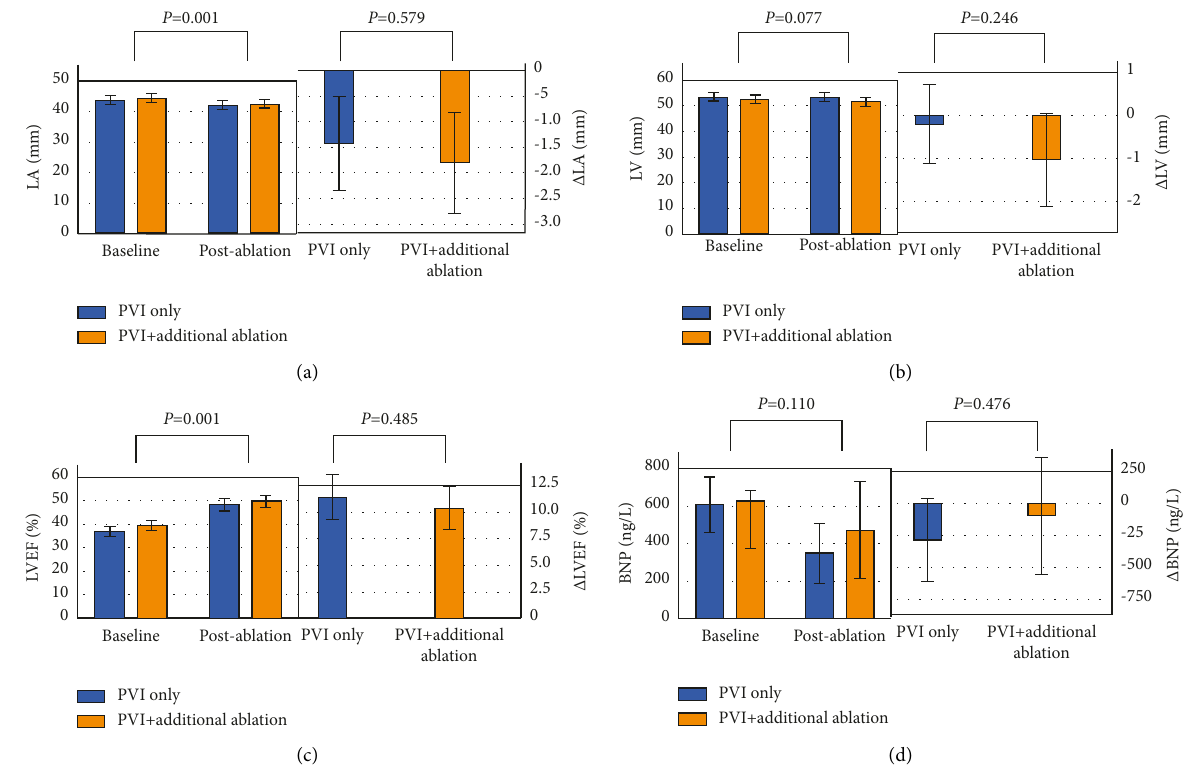
Figure 2: Clustered bar chart of secondary endpoints at baseline and postablation and of the change from baseline to